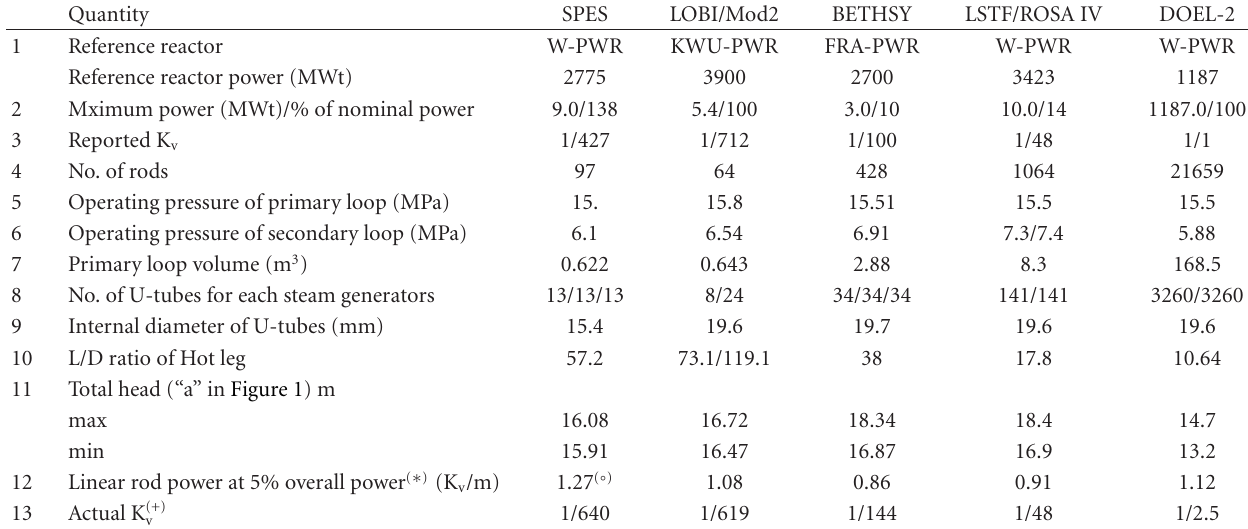
Table 2: Relevant hardware characteristics of considered PWR simulators and Doel-2 nuclear plant.